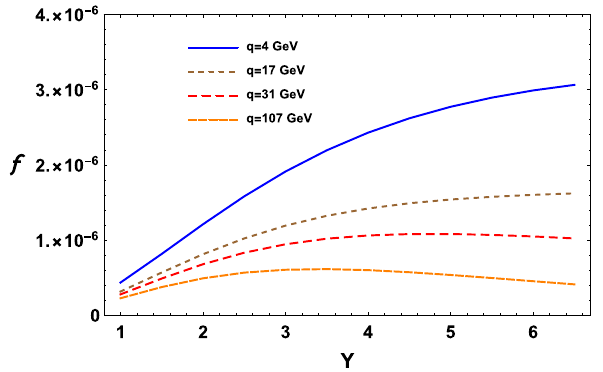
Fig. 9 Energy dependence of f for q = 4 GeV (blue continuous line), q = 31 GeV (red dashed line), q = 17 GeV (brown dashed line) and q = 107 GeV (green dashed line) for the open spin chain